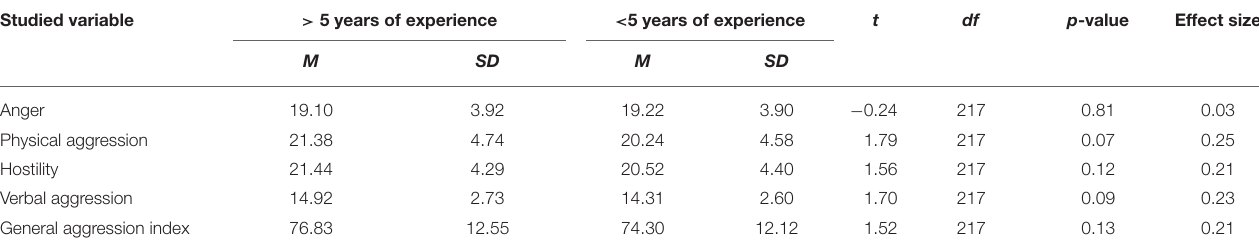
TABLE 5 | The level of aggression dimensions depending on the training experience. Studied variable